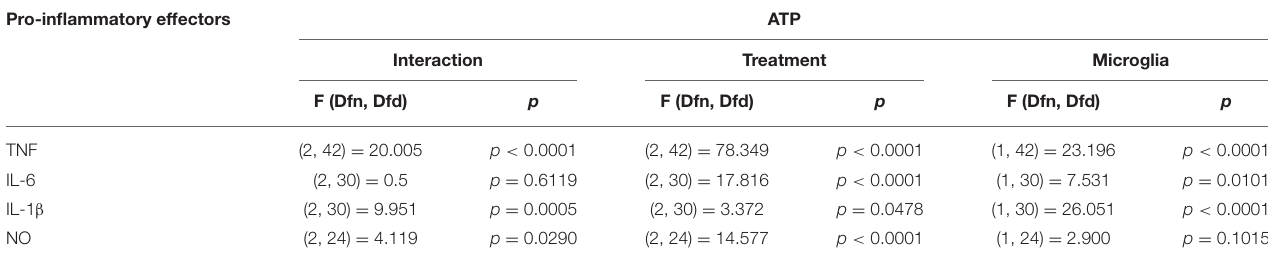
TABLE 1 | Two-way ANOVA details for effect of ATP on SCM and